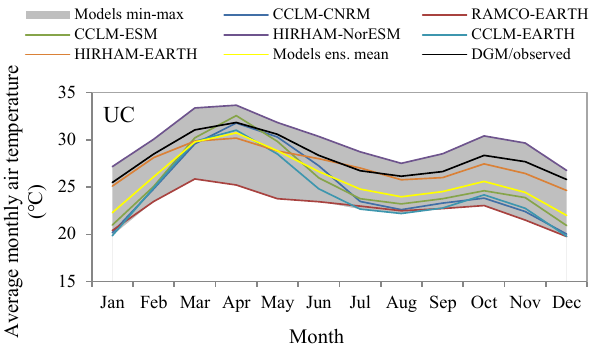
Figure 5. Monthly air temperature derived from climate models and observations for the reference period (1971–2000). Data are not bias corrected. P factor = 100% and R factor =